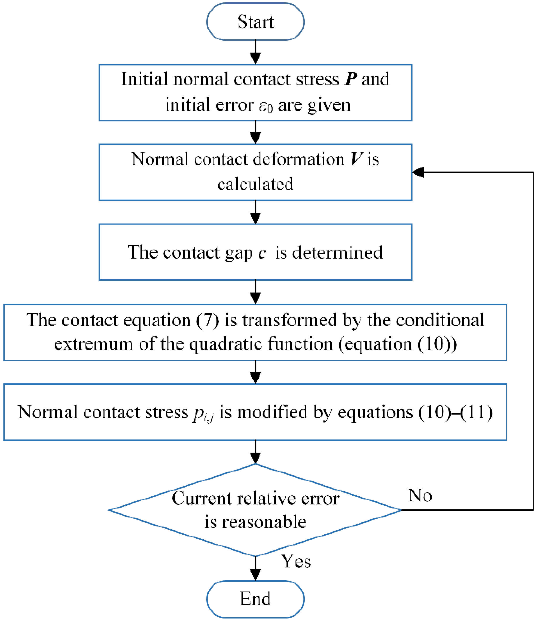
Figure 2. Flowchart for the computation of the non-Hertzian contact stress.